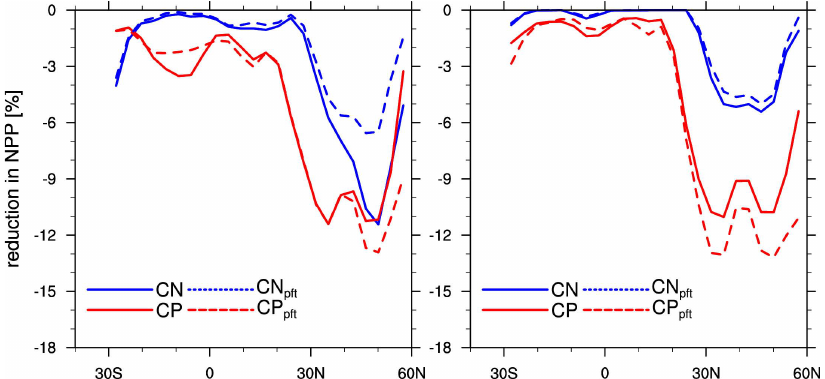
Fig. D2. Mean reduction of NPP (%) due to CNL (N or P) averaged over 30yr (2070–2099 (left) and 2320–2349 (right)) as latitudinal means. Solid line are results from the CN and the CP simulation for N and P limitation, respectively. The dashed lines are results from the sensitivity experiments CP pft and CN pft .